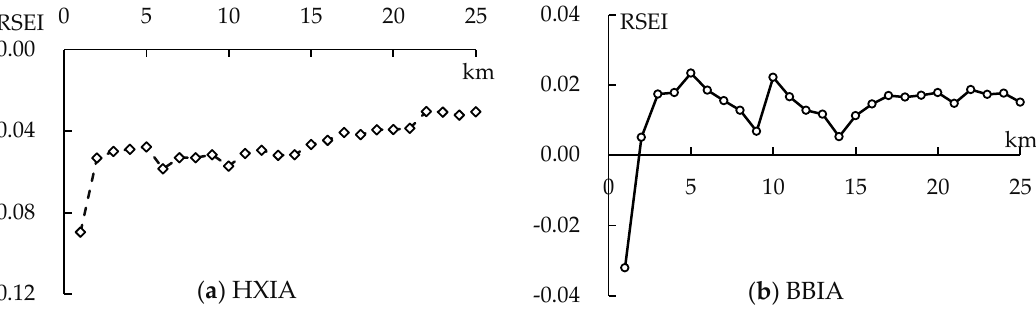
Figure 5. Average annual RSEI variation curves in different buffer zones in ( a ) HXIA and ( b ) BBIA.